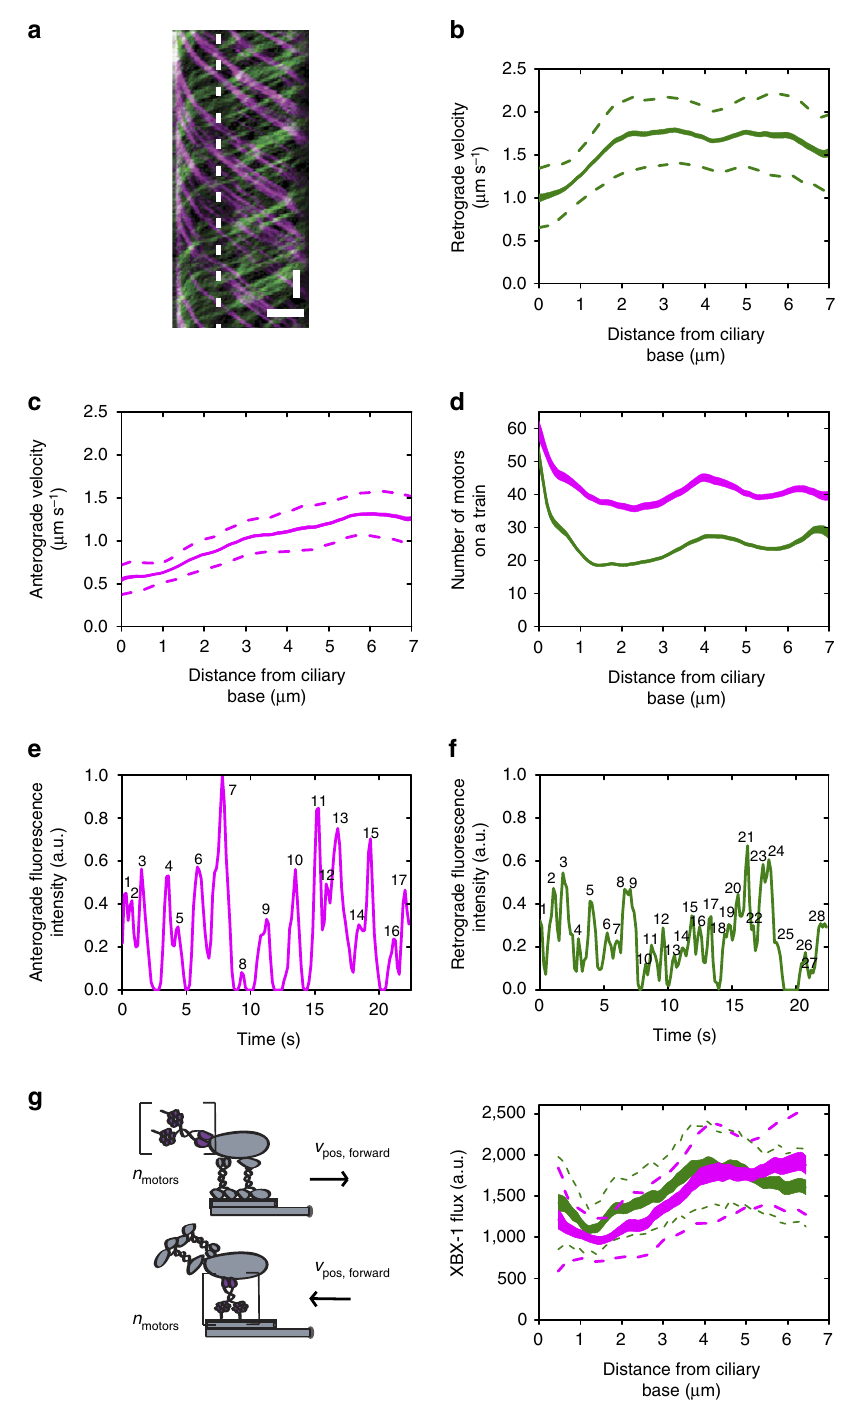
Figure 1 | Characterization of IFT-dynein ensemble dynamics. ( a ) Representative XBX-1::EGFP kymograph showing retrograde (green) and anterograde (magenta) motility. Time: vertical; scale bar, 2s. Position: horizontal; scale bar, 2 m m. ( b ) Train-averaged retrograde IFT-dynein velocity profile. ( c ) Train-averaged anterograde IFT-dynein velocity profile. ( d ) Train-averaged retrograde (green) and anterograde (magenta) XBX-1 train intensity. ( e , f ) Representative intensity versus time profiles of anterograde ( e ) and retrograde ( f ) motility components in ( a ) (location indicated by dotted vertical line). Black numbers are peaks identified using automated peak detection. ( g ) Motor flux is calculated by multiplying the number of motors (area under the curve of the position-dependent fluorescence intensity over time) by the position-dependent velocity. Shown is XBX-1 retrograde (green) and anterograde (magenta) flux in the cilium, n ¼ 30 worms, ( b – d ) averaged over 529 trains obtained from 30 worms (retrograde) and 425 trains from 30 worms (anterograde). Line thickness represents s.e.m.; dotted line represents s.d. See also Supplementary Fig. 1. regulated action models 46,47 . To gain more insight into opposite- OSM-3::mCherry and XBX-1::EGFP KAP-1::mCherry (KAP-1 polarity motor cooperation in C. elegans chemosensory cilia, is a subunit of kinesin-II; Supplementary Table 1). We imaged we generated double-labelled MosSCI strains XBX-1::EGFP the strains using two-colour fluorescence microscopy to NATURE COMMUNICATIONS|8:14591|DOI: